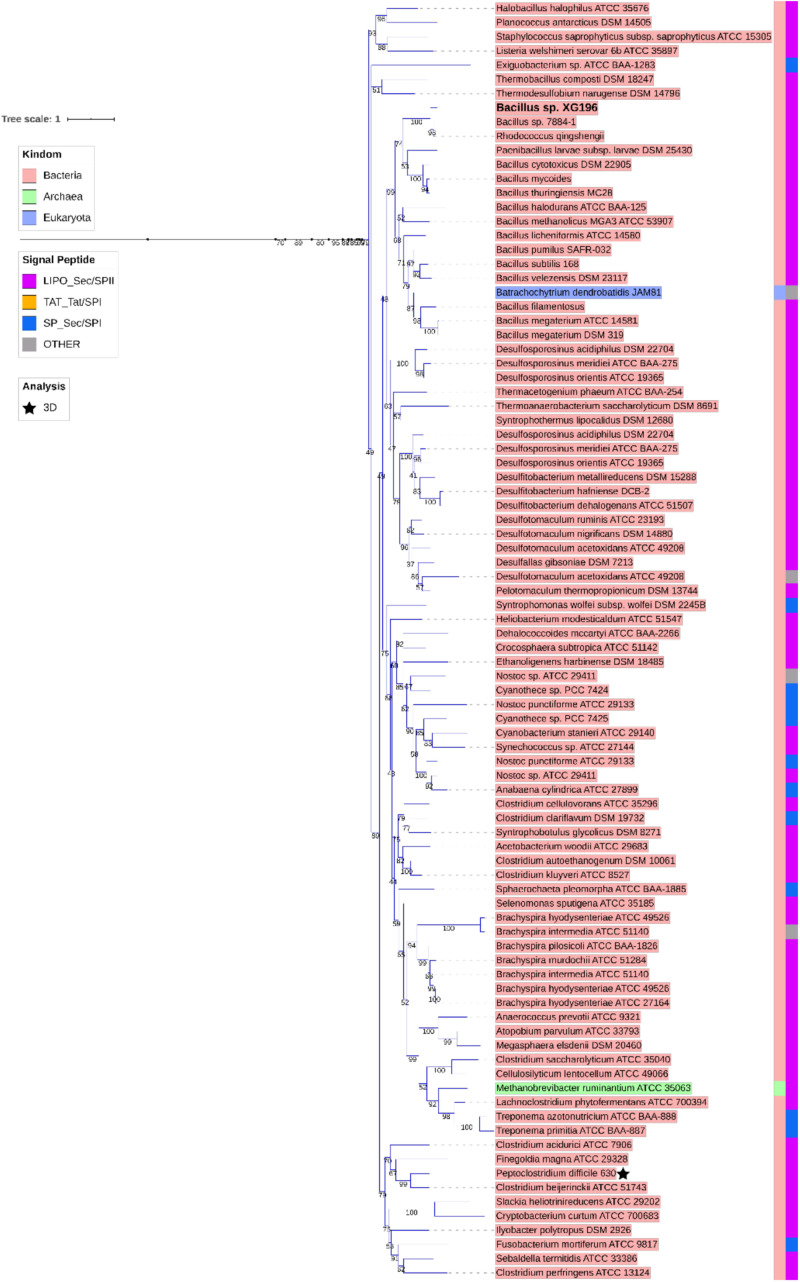
Zoomed-in clade of XG196 ModA and its close relatives. Bootstrap data are shown in the middle of each branch.